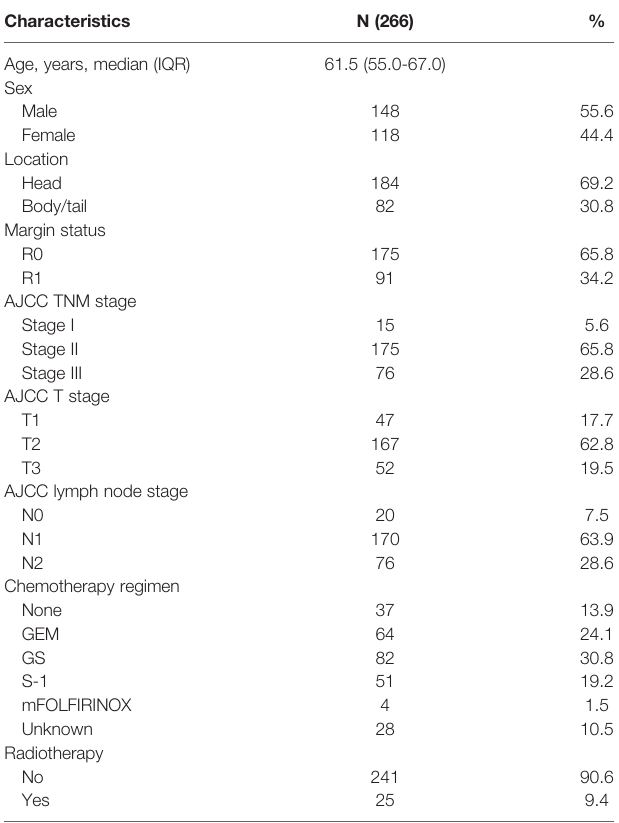
TABLE 1 | Baseline characteristics of 266 patients with lymph node metastasis or R1 resection after surgery for resectable pancreatic adenocarcinoma.